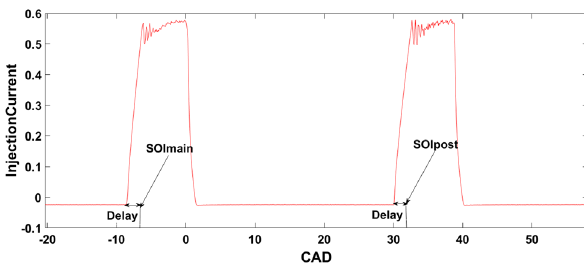
Figure 1: A main and a post - injection current signal and parameter de